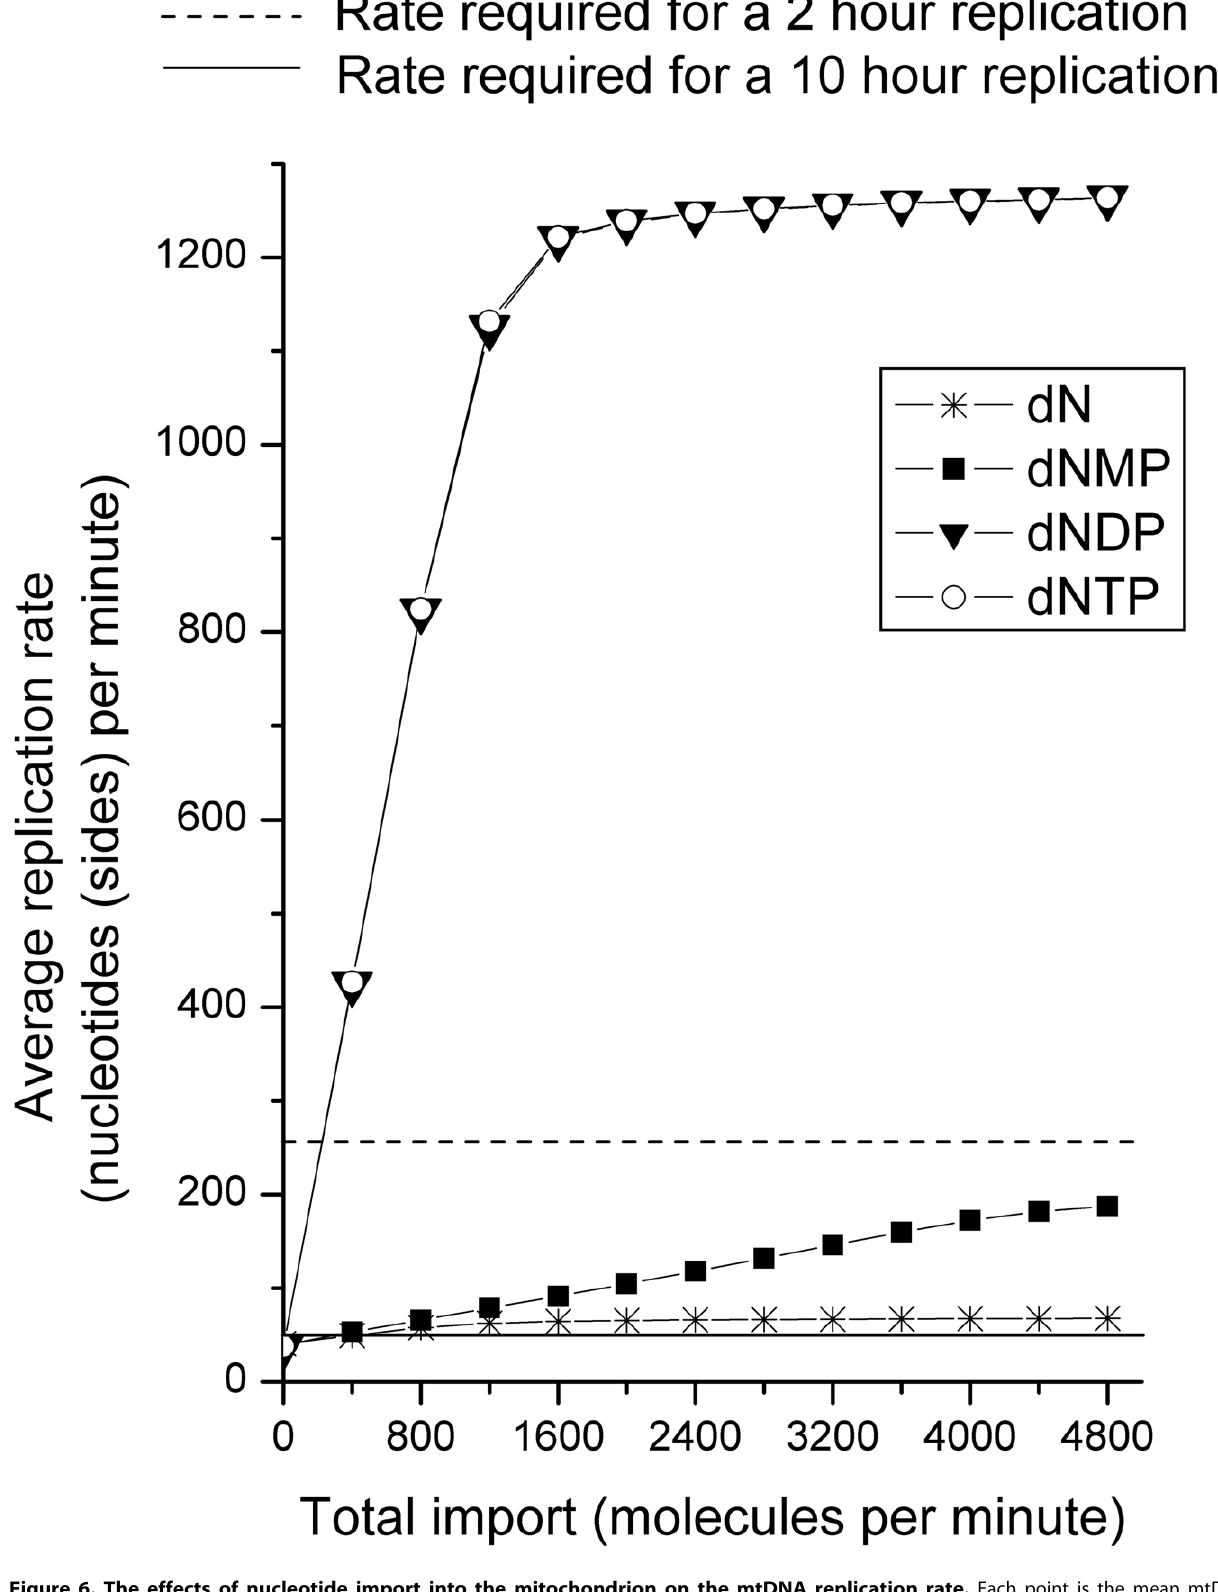
Figure 6. The effects of nucleotide import into the mitochondrion on the mtDNA replication rate. Each point is the mean mtDNA replication rate from 100 simulations with different randomly chosen initial concentrations of deoxynucleosides and deoxynucleotides. The X-axis represents the total amount of additional deoxynucleosides or deoxynucleotides supplied (sum total of equal amounts for each of the four species). Additional supply of dN, dNMP, dNDP or dNTP were simulated separately. The dNTP output from mitochondrial salvage alone is insufficient to